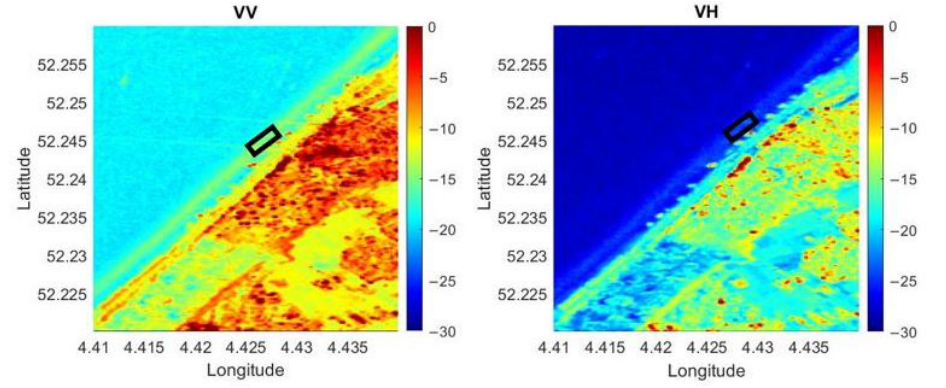
Figure 4. Sentinel-1 images (Left: VV polarisation; Right: VH polarisation): sigma nought values averaged over the period of interest (19 August 2019 to 22 April 2021) from the orbit DSC37 showing the city of Noordwijk and its coast line with the study area highlighted in the black